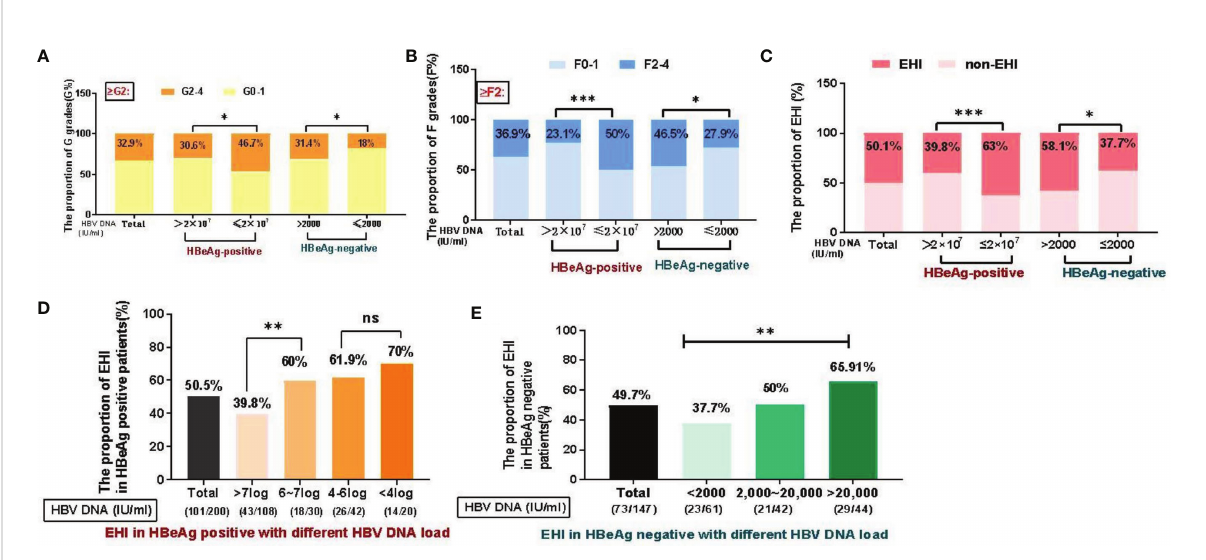
FIGURE 2 Distribution of liver in fl ammation and fi brosis in different immune status groups (%). (A) Signi fi cant differences in liver in fl ammation were observed among the groups. (B) Signi fi cant differences in liver fi brosis were observed among the groups. (C) EHI in different immune phases. (D) In the HBeAg-positive patient cohort, the overall proportion of EHI was 50.5% (101/200), 39.8% of patients with >7 log DNA load had EHI (43/ 108), followed by a decreased HBV DNA load, and 60 – 70% of subjects (18/30, 26/42, 14/20) had EHI (X 2 =11.2, P=0.01). (E) For HBeAg-negative patients, the overall proportion of EHI was 49.7% (73/147). The proportion of EHI in IHC (HBV DNA<2000 IU/ml) was signi fi cantly lower (37.7%) than that in patients with a higher HBV DNA load (50%~77.3%, X2=10.4, P=0.02). *p <0.05, **p <0.01, ***p <0.001; ns, not signi fi cant.